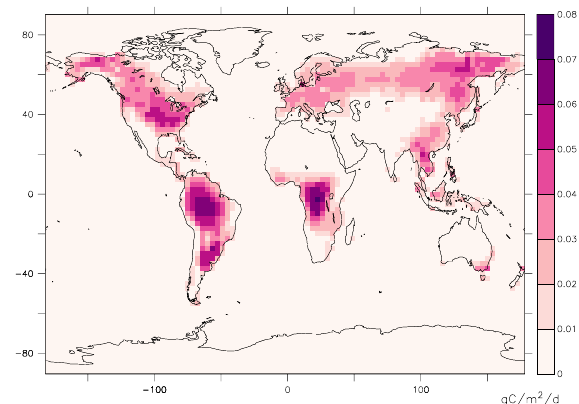
Fig. 3. RMS differences for annual CO 2 fluxes between the PP in- version and its prior for the period 1979–2010 (black, PP-PRIOR), between the 1979–2010 PP inversion and the 1979–2010 reference inversion for the same period (blue, PP-REFlong) and between the 1979–2010 PP inversion and the 1979–1992 reference inversion for 1979–1991 (red, PP-REFshort). The world is split into the 22 TransCom3 regions.